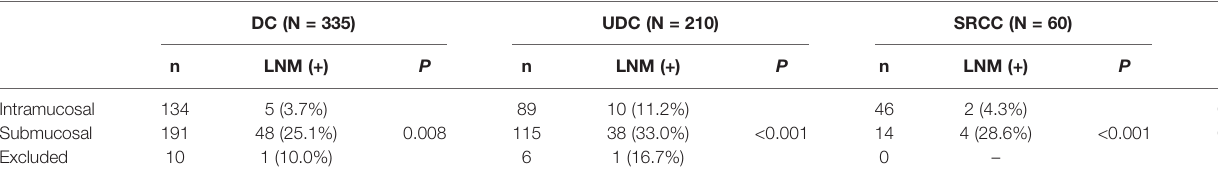
TABLE 4 | Lymph node metastasis in intramucosal and submucosal cases of three pathological